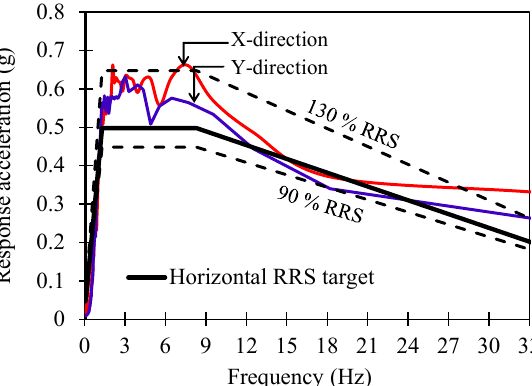
Figure 7. Comparison between the input spectra of AC156_100 and required response spectrum (RRS) target.